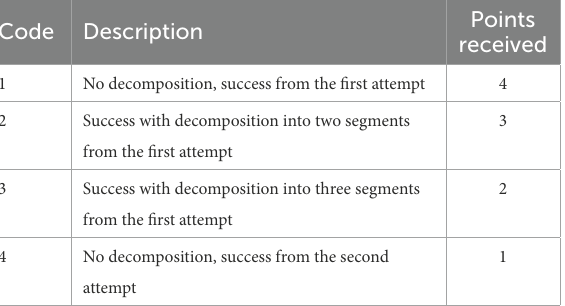
TABLE 6 Computational thinking assessment rubric.